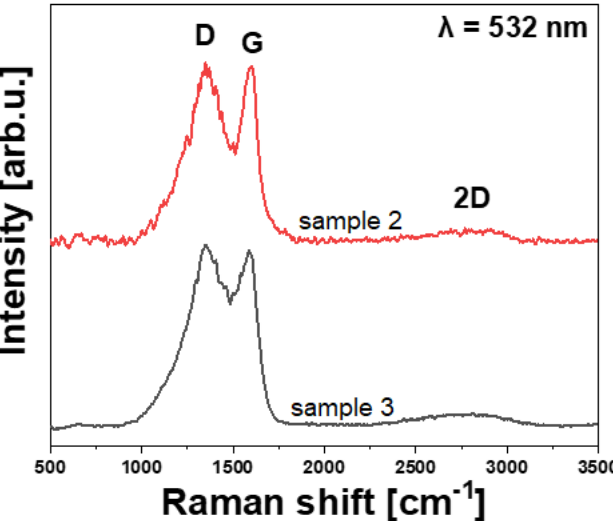
Figure 7. Raman spectra of the examined CFRP laminates in the epoxy matrix regions.